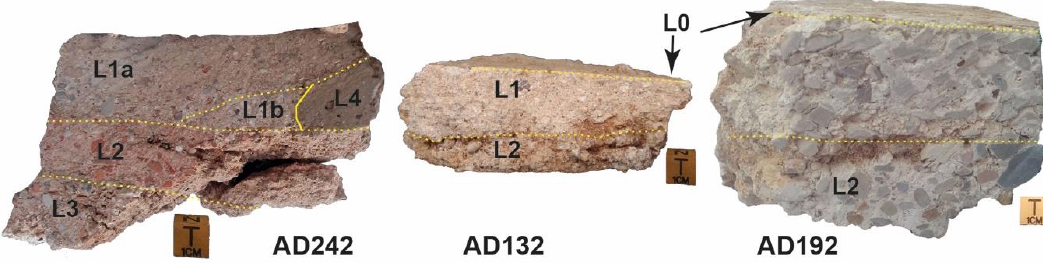
Figure 2. Representative samples of mortars from the Arroyo de la Dehesa de Velasco site. Sample AD-242: Multilayer wall plaster with cocciopesto layer. Sample AD-132: Two layers of wall siliceous plaster with an outermost marmorino layer. Sample AD-192: Multilayer floor mortar with three layers, L0 marmorino layer, L1 crushed limestone and L3 siliceous pebbles with calcite binder.